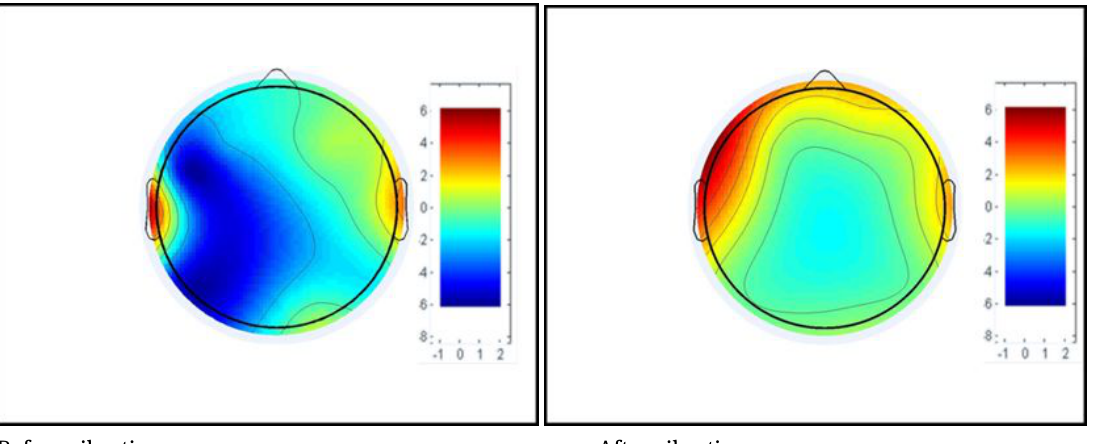
Fig. 6. Figure shows scalp topography images of theta activity before and after vibration. Higher activity was recorded at frontal area after vibration.